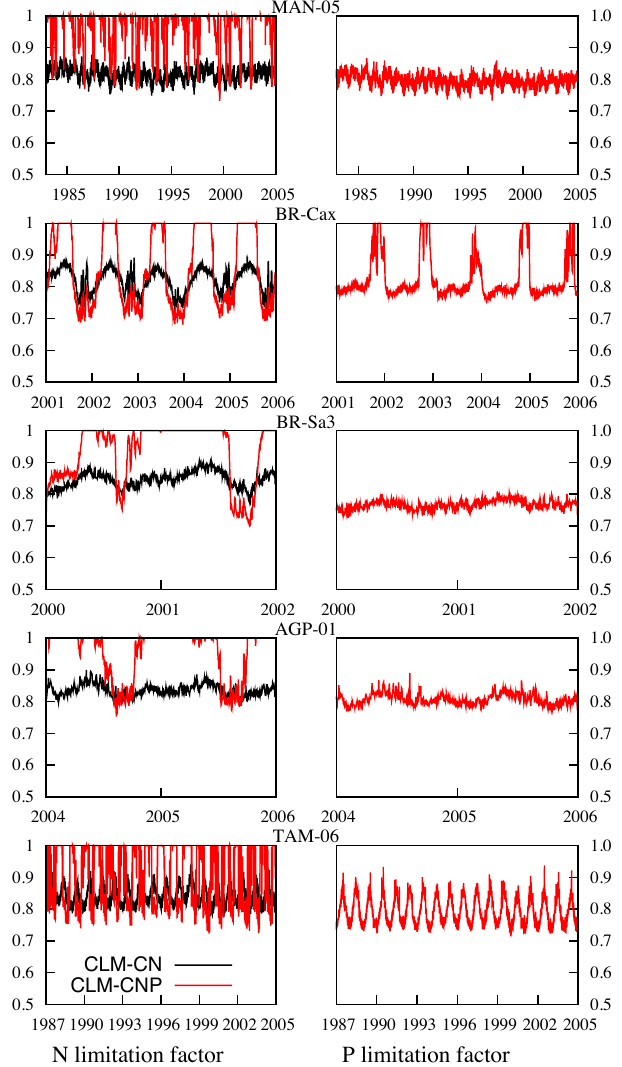
Fig. 5. The extent of nutrient limitation (N and P for CLM-CNP, N Fig. 5: The extent of nutrient limitation (N and P for CLM-­‐CNP, N for CLM4-­‐CN) for for CLM4-CN) for the five Amazonian the five Amazonian sites